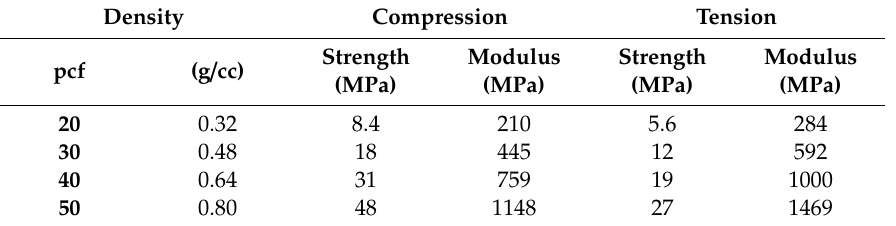
Figure 1. ( A ) Schematic diagram of the miniscrew, where diameter (D) = 1.8 mm and length (L) = 10 mm. Digital photographs of ( B ) an artificial bone block, and ( C ) miniscrews inserted at different intrabony lengths. Table 1. Mechanical properties of the polyurethane foam bone blocks with different densities.